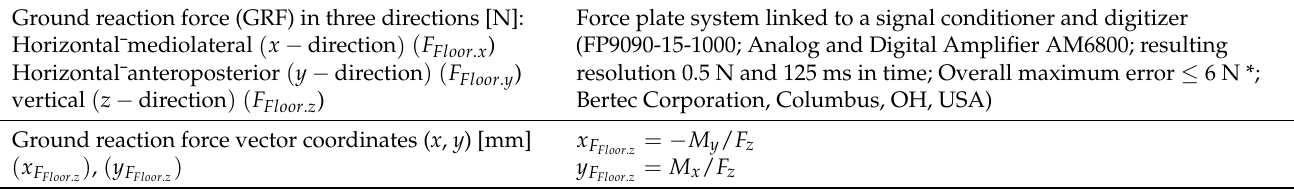
Table A1. Selection of variables used for the model (forces, coordinates, angles, anthropometrics and segment measures of the